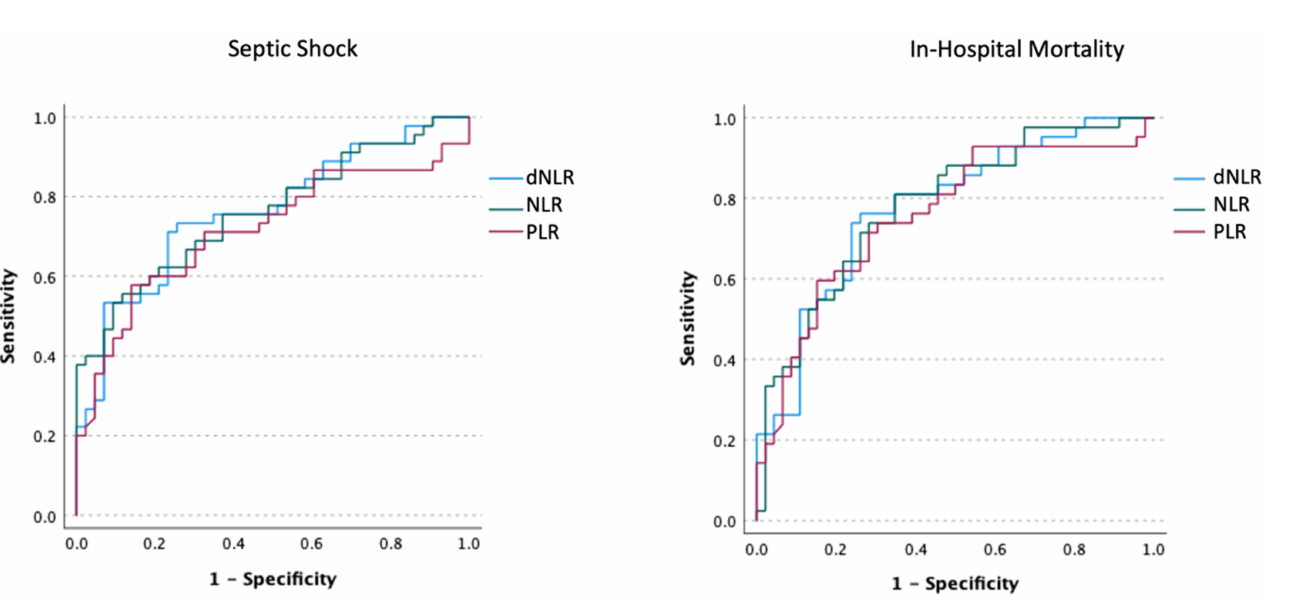
Figure 2. Area under the receiver-operating characteristic curve analysis for discriminating progres- sion towards septic shock ( left ) and in-hospital mortality ( right ) for the neutrophil-to-lymphocyte ratio, derived neutrophil-to-lymphocyte ratio, and platelet-to-lymphocyte